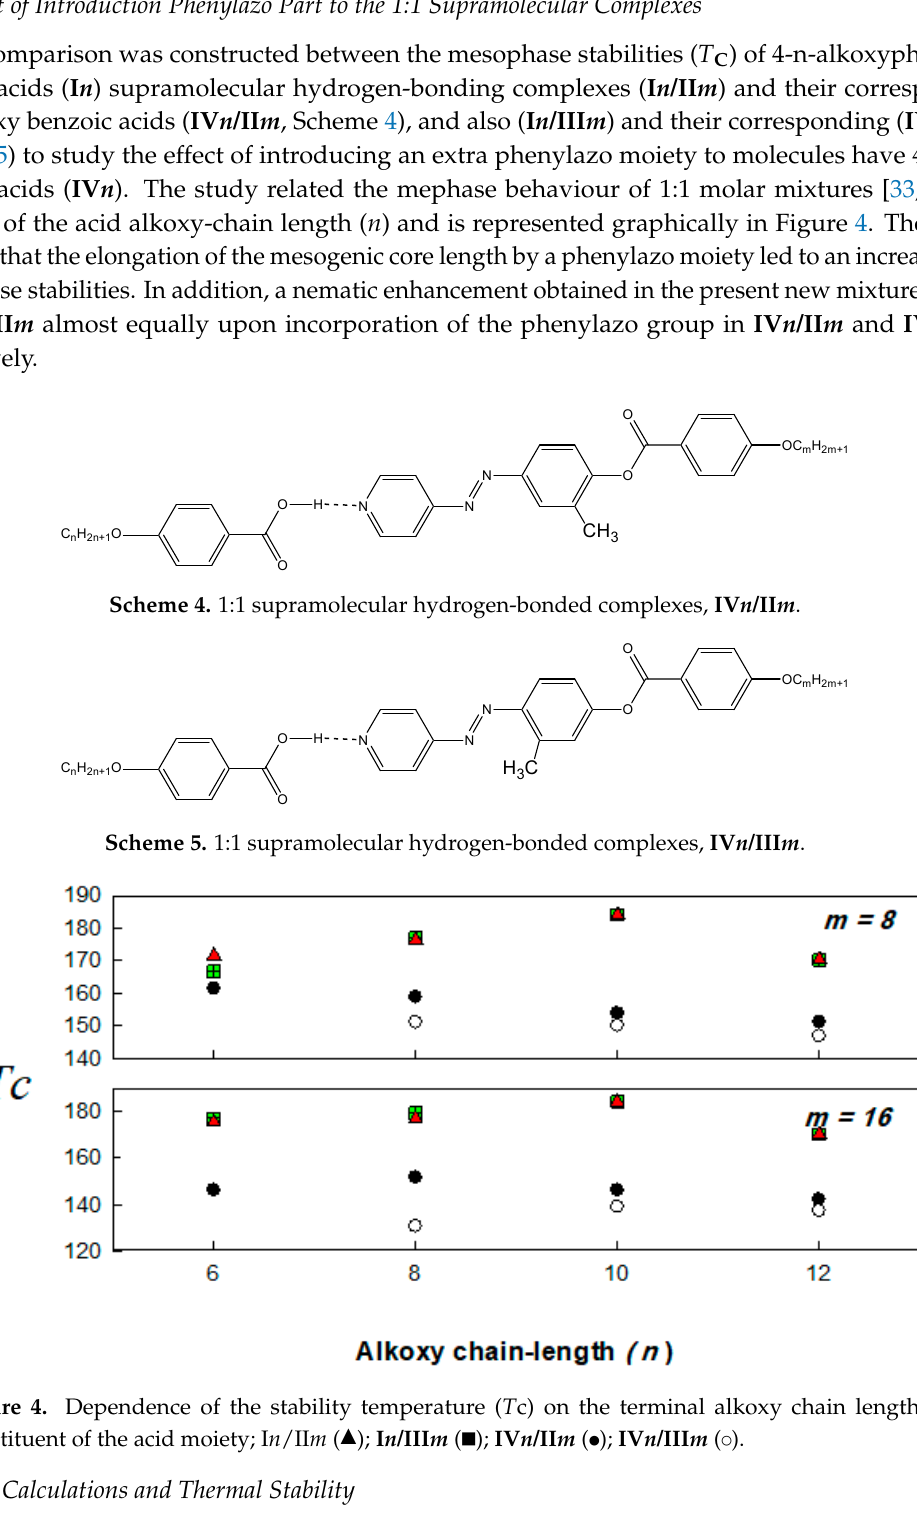
Figure 5. Calculated geometrical structure of I 12 , II 16 , III 16 , I 12 /II 16 and I 12 /III 16 . Table 2 illustrates the calculated total energies, dipole moments and thermodynamic functions of the studied complexes ( I 12 /II 16 , I 12 /III 16 ) as well as the acid ( I 12 ) and the bases ( II 16 , III 16 ). DFT calculations showed the extra stability of the complex I 12 /II 16 with respect to I 12 /III 16 by 2.3657 Kcal/mol and 2.8589 Kcal/mol, enthalpy change and Gibbs free energy change, respectively. Moreover, all compounds are polar. However, the position of the methyl group affects the polarity,